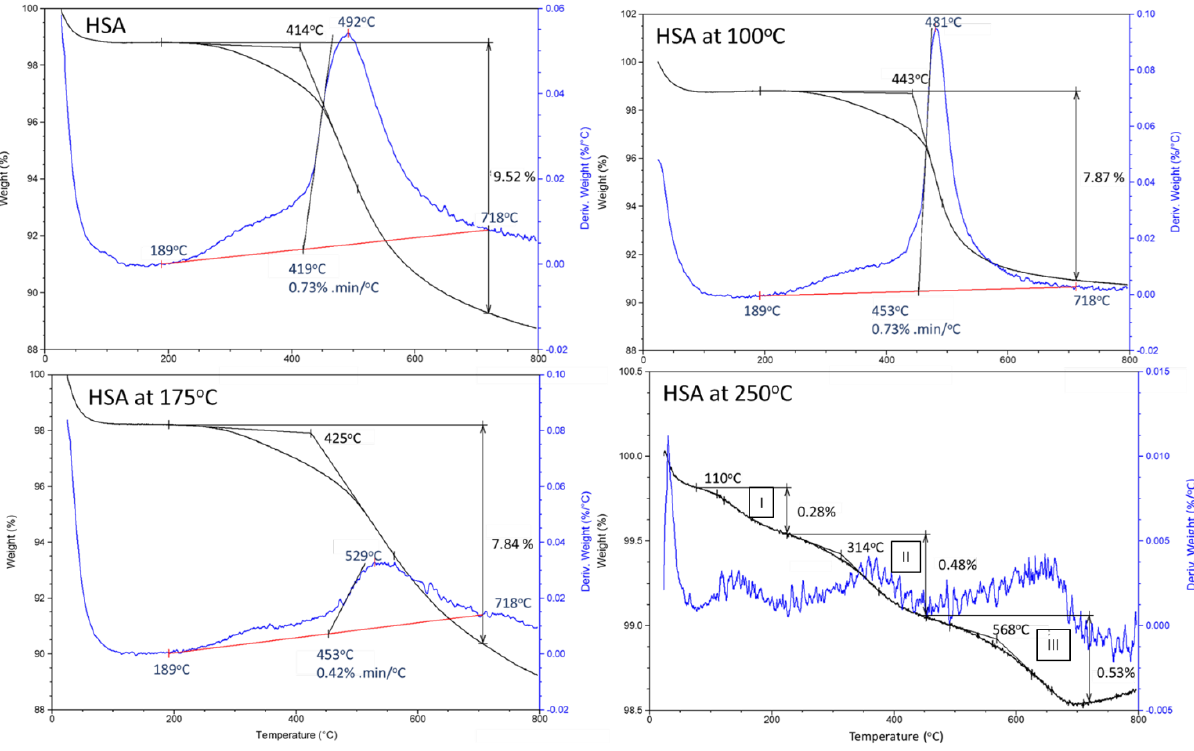
Figure 4. TGA/DTG analyses for 100, 175, and 250 °C-autoclaved HSA.